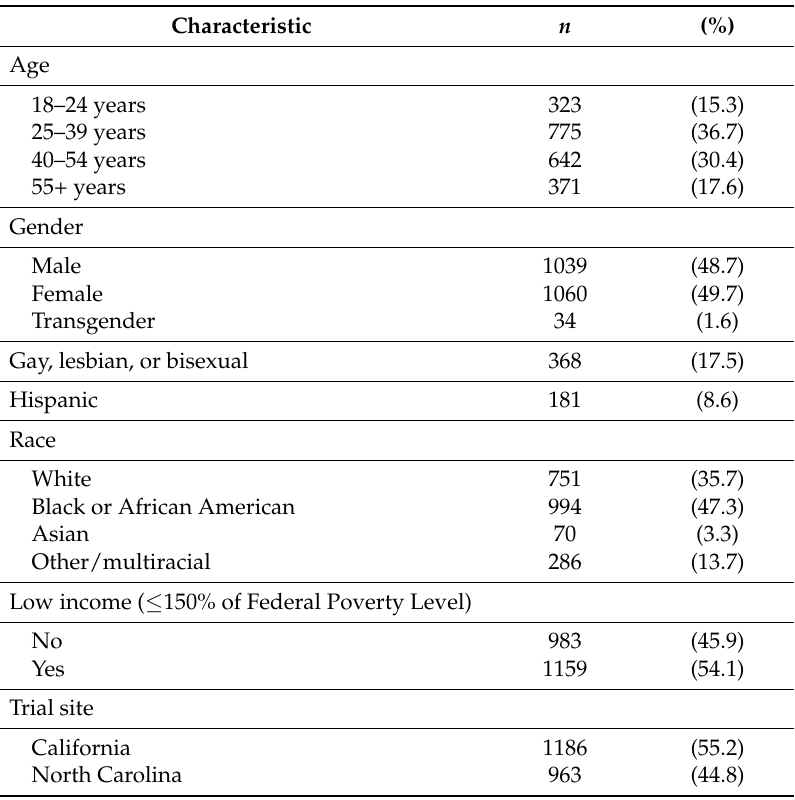
Table 2. Participant Characteristics ( n =